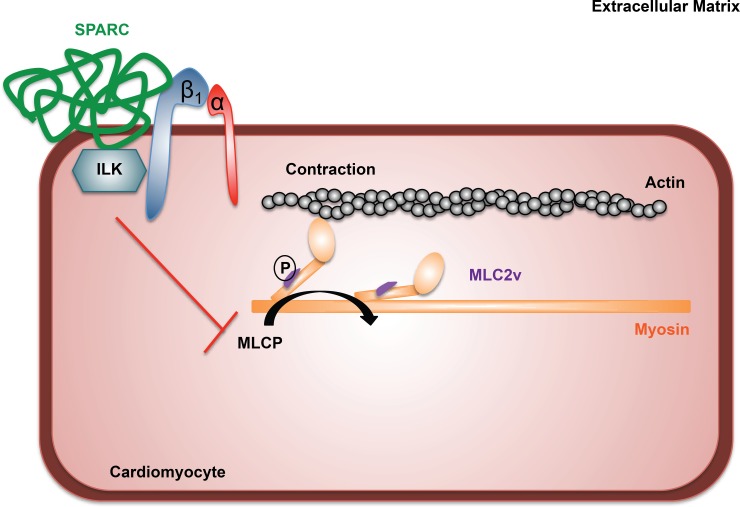
Proposed mechanism on how SPARC increases cardiomyocyte contraction.